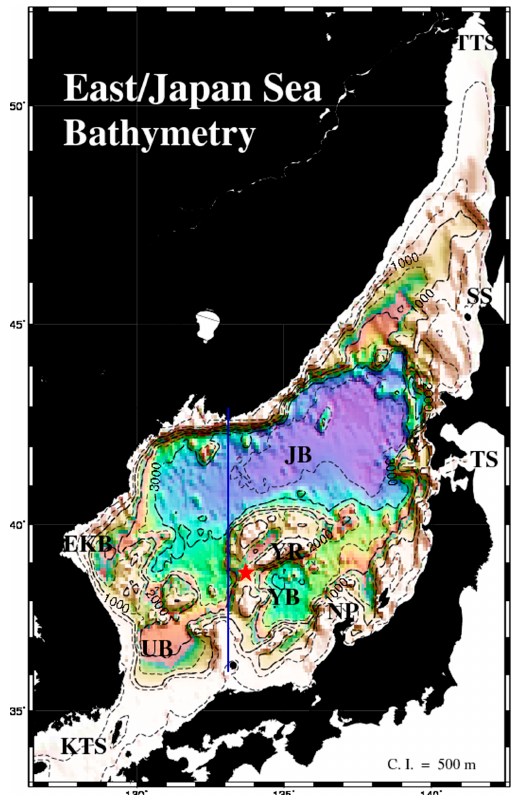
Figure 1. Study area and bathymetry (m). The contour interval is 500 m. KTS: Korea/Tsushima Strait, TS: Tsugaru Strait, SS: Soya Strait, TTS: Tatar Strait, UB: Ulleung Basin, YB: Yamato Basin, JB: Japan Basin, YR: Yamato Rise, EKB: East Korean Bay, NP: Noto Peninsula. The solid blue line along the 133 °E line is for the vertical section and the red star denotes the position of the site used for the analysis related to the near-inertial motions.